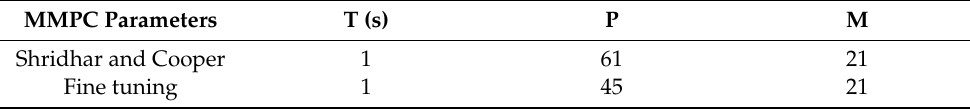
Table 6. MMPC parameters on the steam reformer unit.